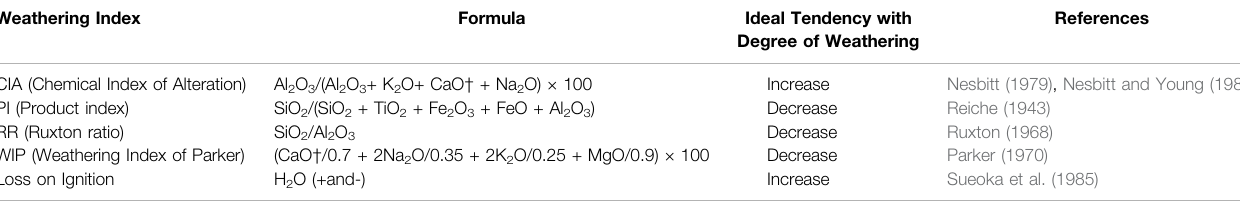
TABLE 4 | Chemical weathering indices used in this study.